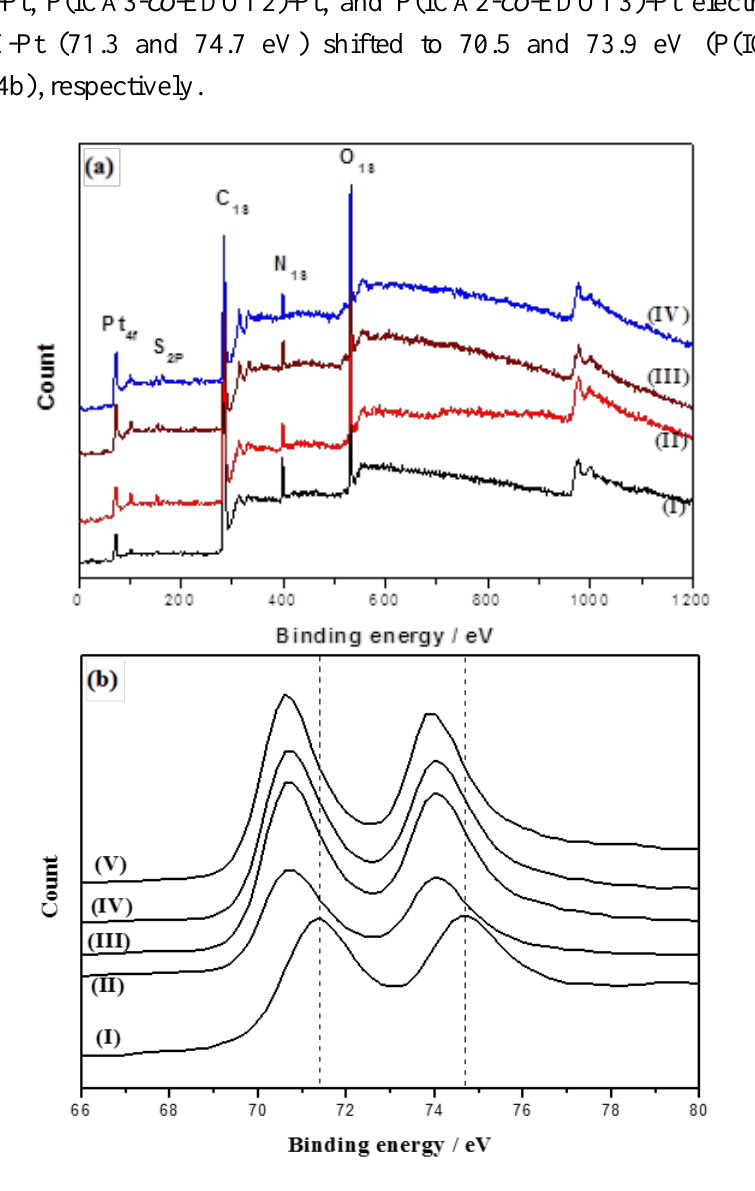
Figure 4. ( a ) XPS spectra of the survey scan (I) PICA-Pt, (II) P(ICA4- co -EDOT1)-Pt, (III) P(ICA3- co -EDOT2)-Pt, and (IV) P(ICA2- co -EDOT3)-Pt; ( b ) Pt 4f XPS core-level spectra of (I) E-Pt, (II) PICA-Pt, (III) P(ICA4- co -EDOT1)-Pt, (IV) P(ICA3- co -EDOT2)-Pt, and (V) P(ICA2- co